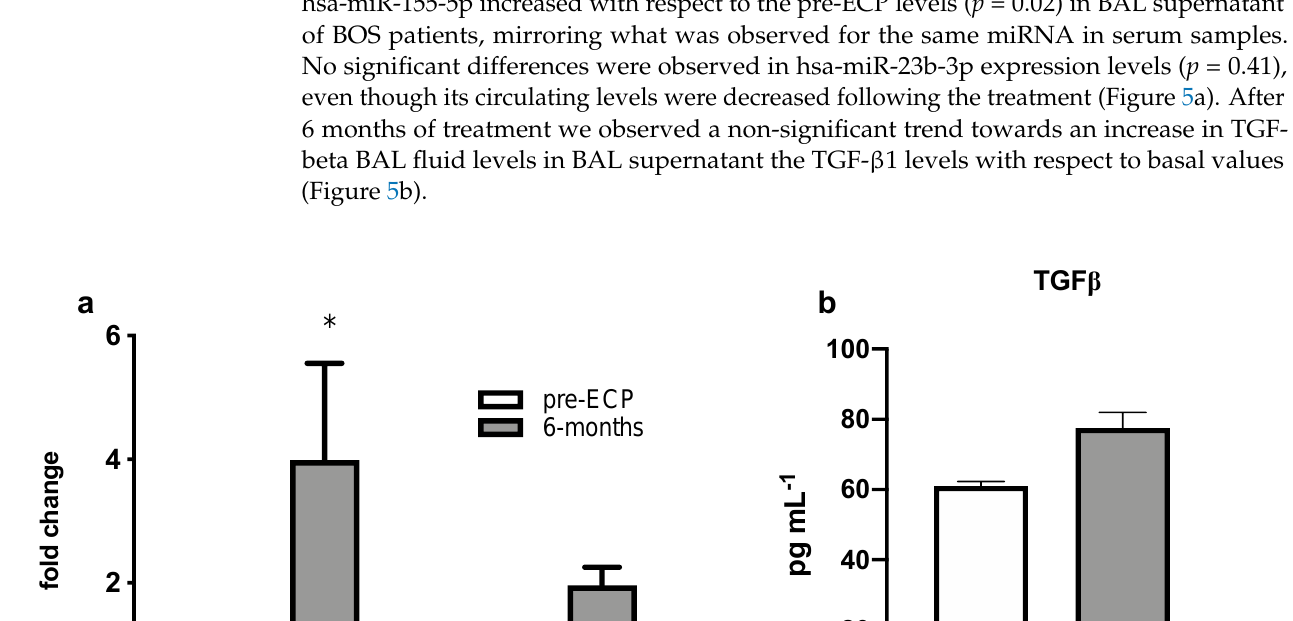
assessed by qRT-PCR in PBMCs of BOS patients. * p < 0.05 . 3.5. Expression Levels of Dysregulated miRNAs and TGF-b Levels in BAL Supernatant